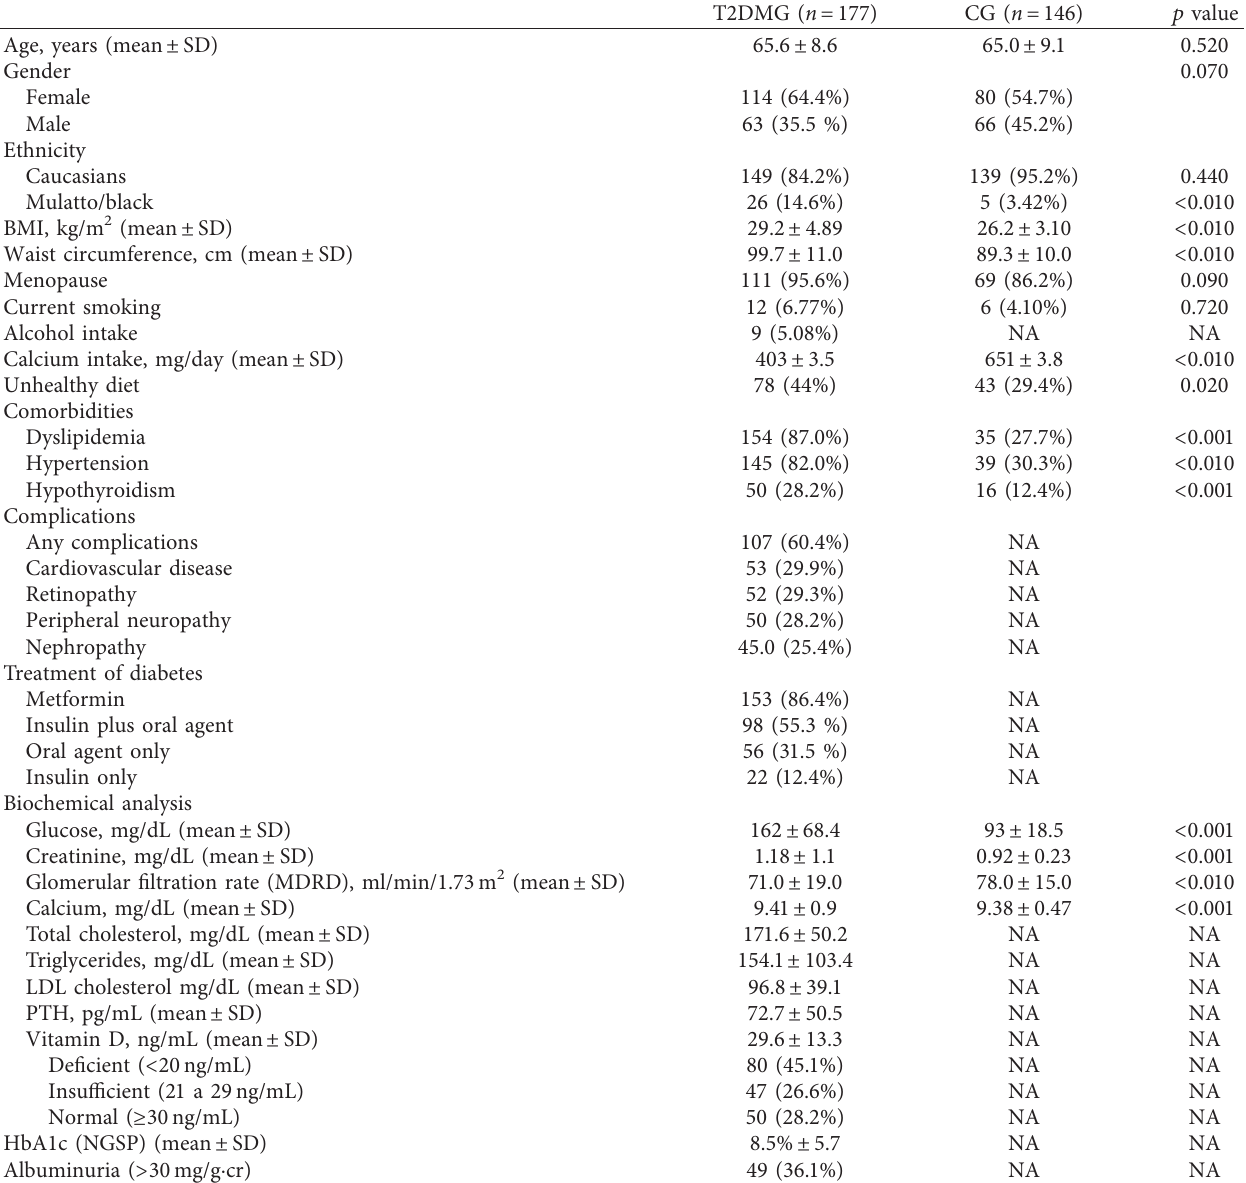
Table 1: Clinical and biochemical characteristics of patients with type 2 diabetes mellitus (T2DM) and